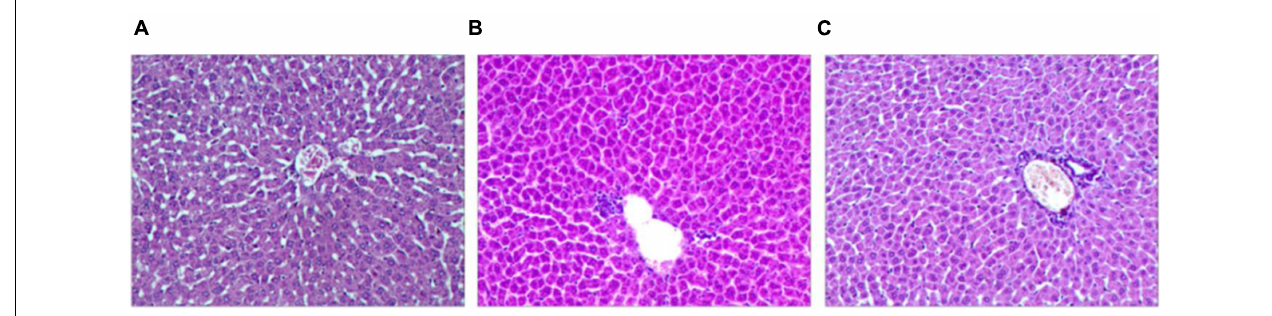
Figure 4 | Hematoxylin and eosin staining of rat liver tissue ( × 200). (A) The plain group(P). (B) The high altitude group (H1). (C) The high altitude group (H2).